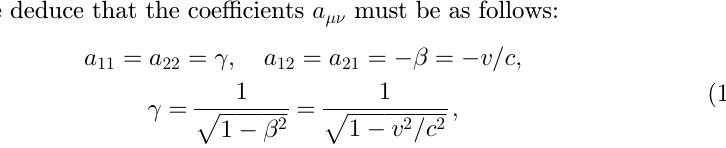
1 ffiffiffiffiffiffiffiffiffiffiffiffiffi ¼